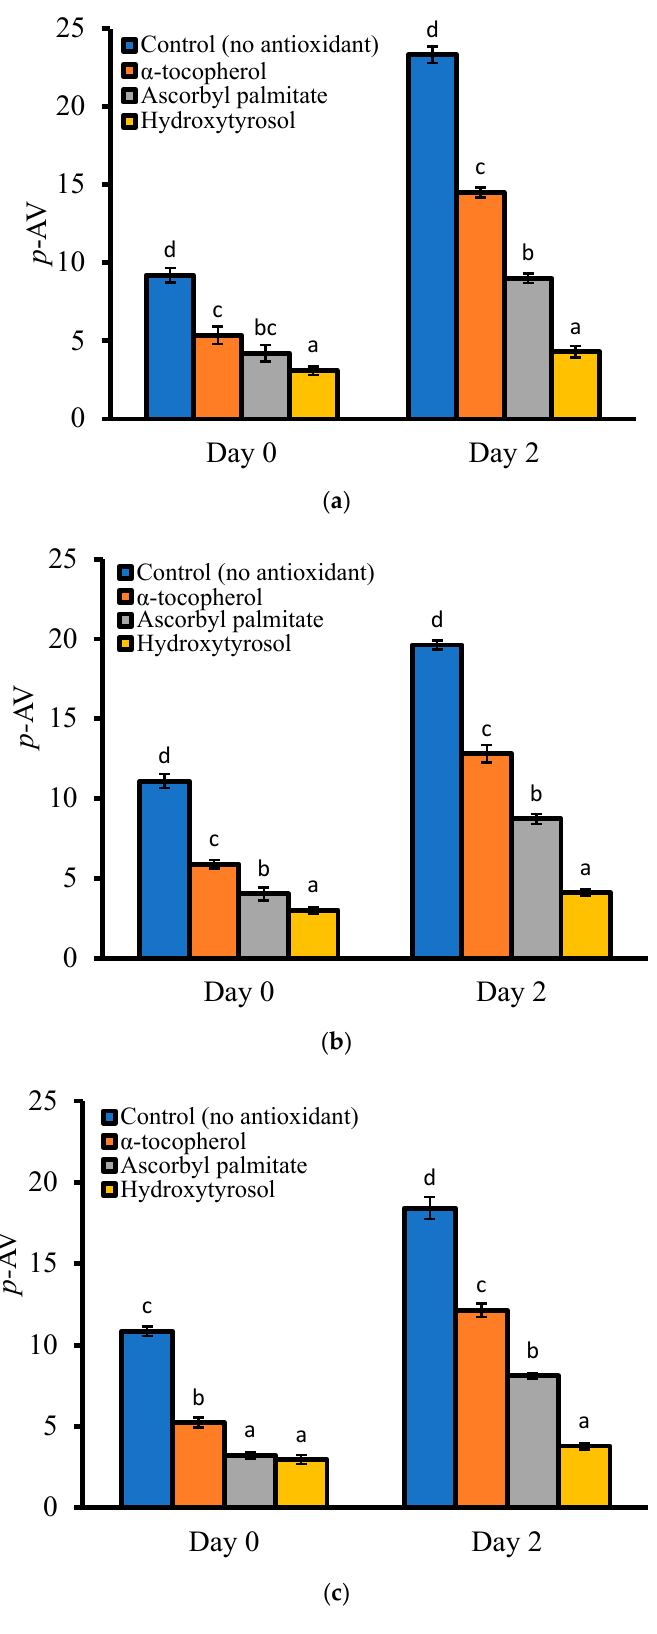
Figure 4. The p -Anisidine values ( p -AV) of oil extracted from ( a ) squid, ( b ) hoki and ( c ) prawn after deep frying and refrigerated storage. Values are expressed as mean ± standard deviation ( n = 3). Bars not sharing a common letter are significantly different ( p < 0.05) within each